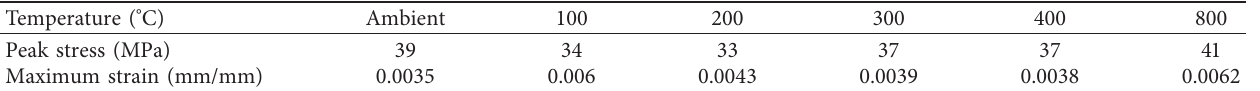
Table 6: Stress-strain relationship for M3 samples at elevated temperatures.